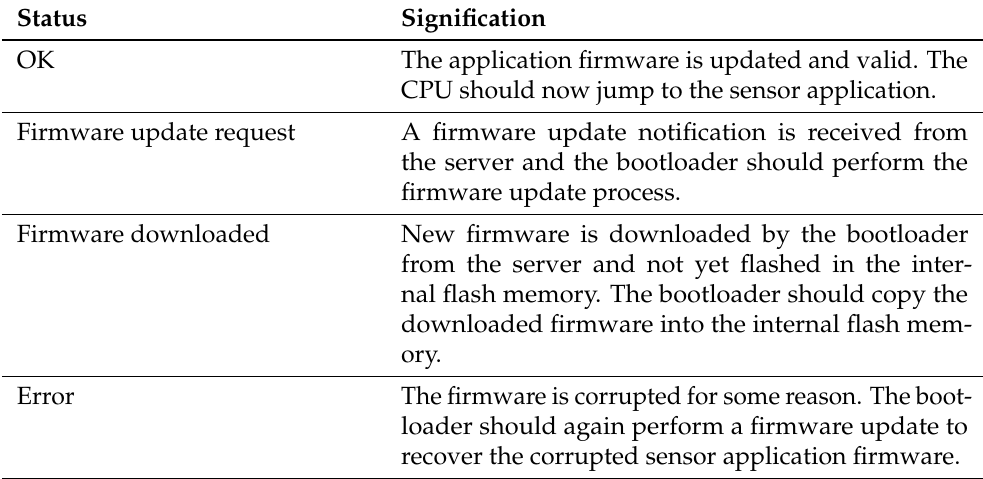
Table 1. Mailbox sensor application status